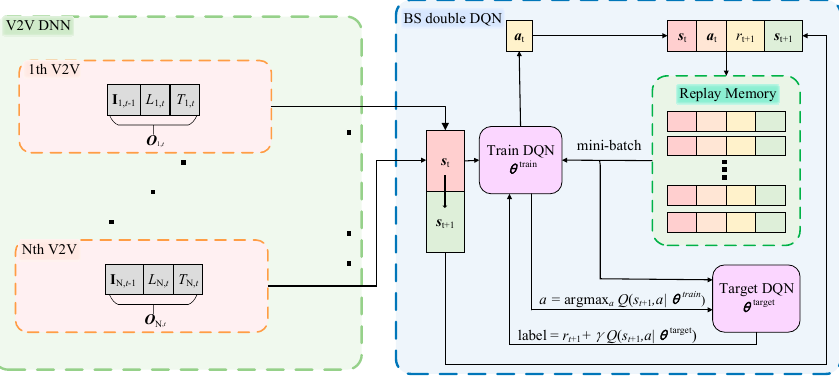
Figure 2. Proposed framework for resource allocation.